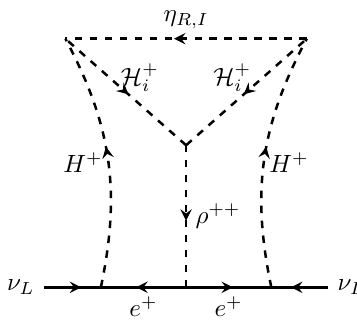
Figure 21 . Mass diagram after EWSB in the Feynman-’t Hooft gauge. H + is the Goldstone boson associated to W (cid:22) with mass m W